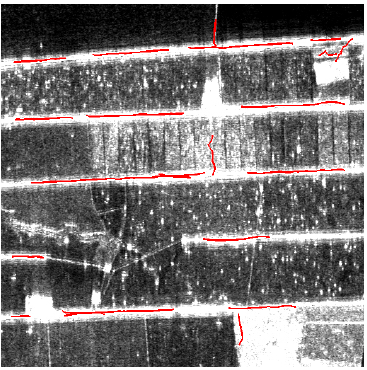
Figure 7: Results of the road extraction method (Cut 1).